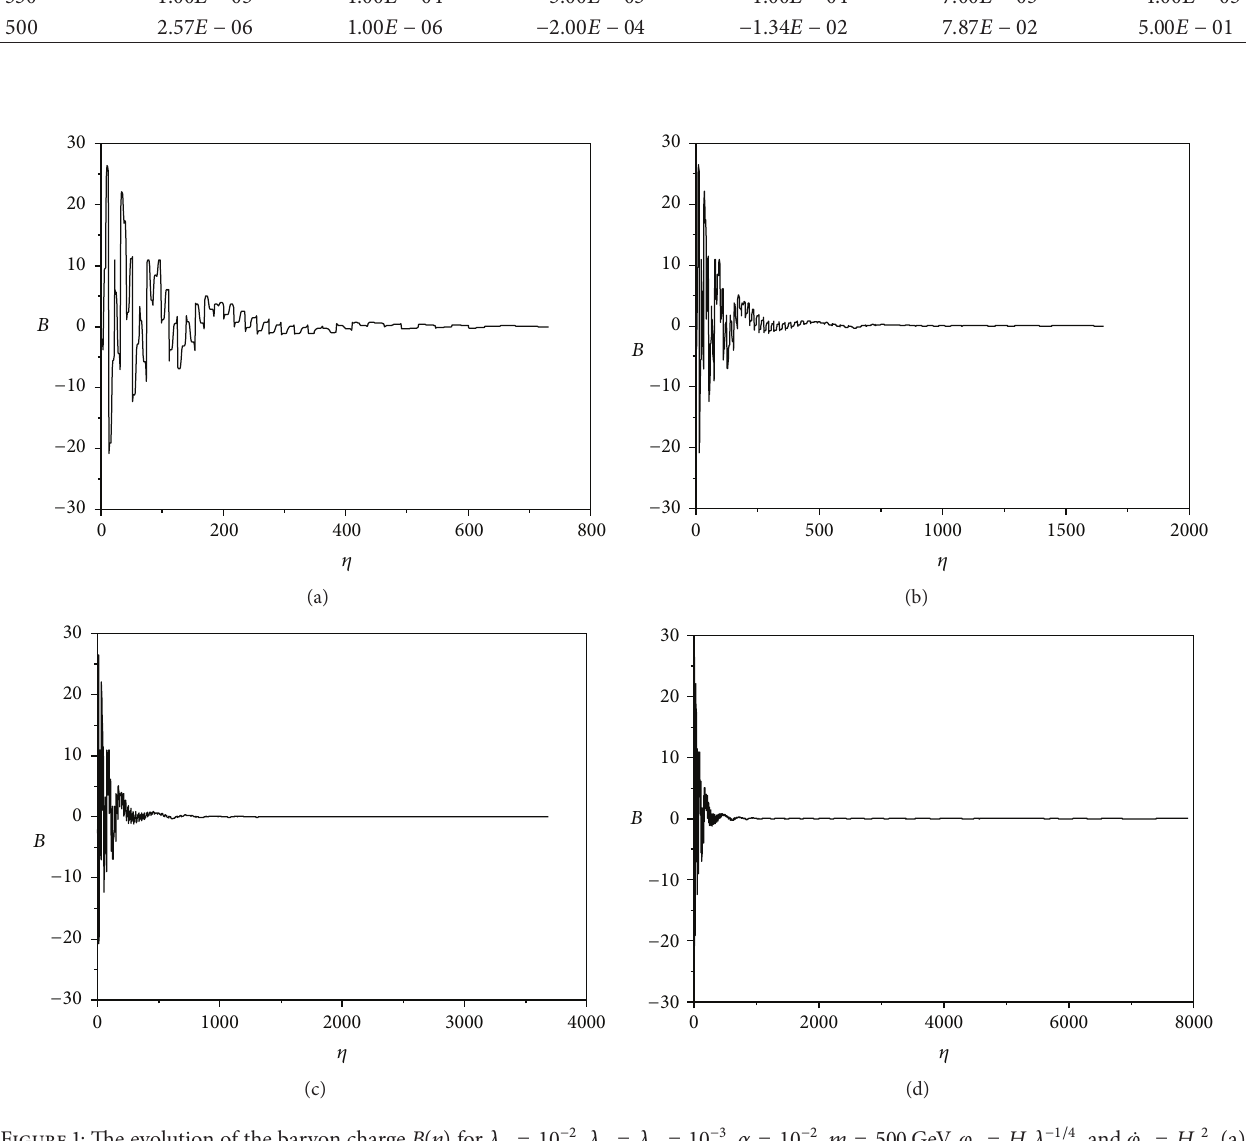
Figure 1: The evolution of the baryon charge 𝐵(𝜂) for 𝜆 1 = 10 −2 , 𝜆 2 = 𝜆 3 = 10 −3 , 𝛼 = 10 −2 , 𝑚 = 500 GeV, 𝜑 𝑜 = 𝐻 𝐼 𝜆 −1/4 , and ̇𝜑 𝑜 = 𝐻 𝐼2 . (a) For 𝐻 𝐼 = 10 9 GeV, (b) for 𝐻 𝐼 = 10 10 GeV, (c) for 𝐻 𝐼 = 10 11 GeV, and (d) for 𝐻 𝐼 = 10 12